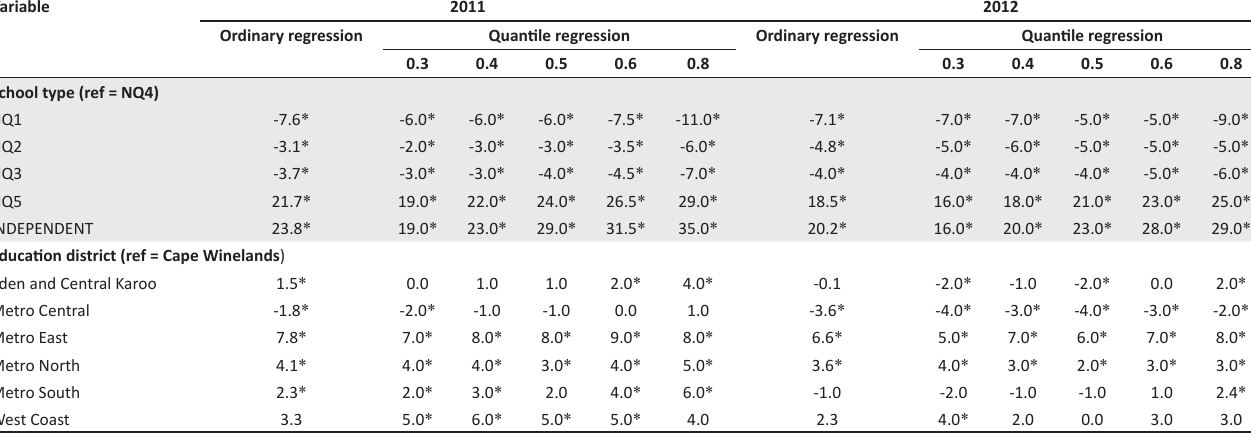
TABLE 1b: Results from the estimation of the determinants of learner marks in the National Senior Certificate mathematics.